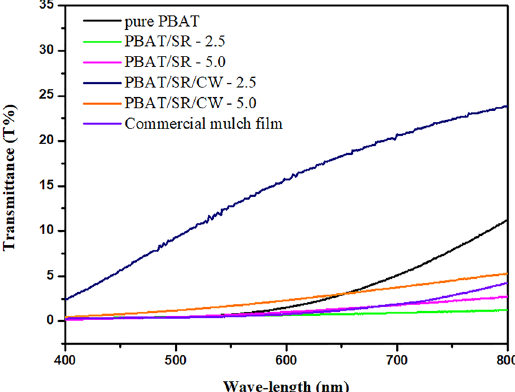
Figure 10. Percentage of light transmitted by pure PBAT and mulch films. (colored in the online version)